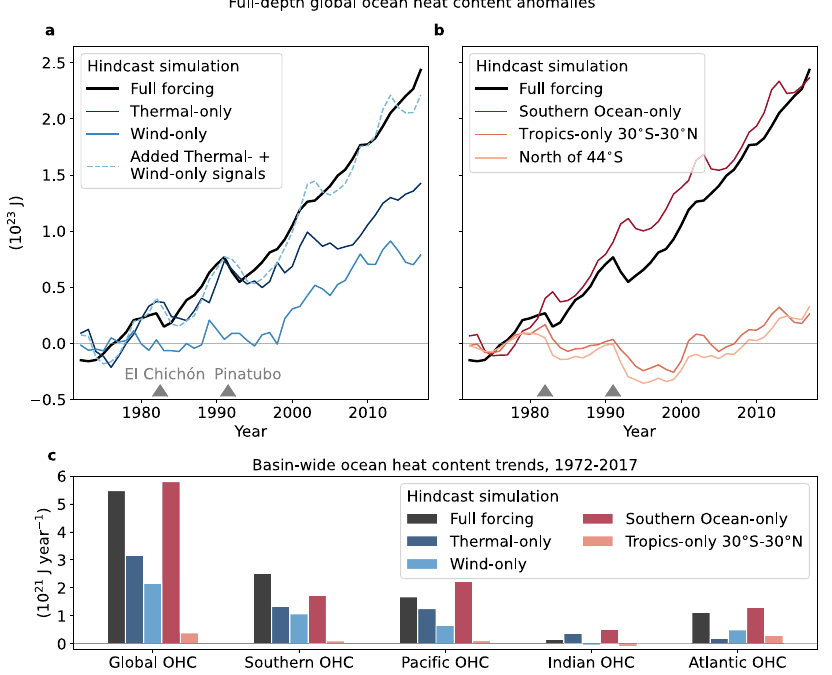
Fig.4|Simulatedglobalandregionaloceanheatcontent(OHC)changesdueto thermal/wind trends and due to regionally-constrained atmospheric trends. a Time series of full-depth global ocean heat content anomalies (10 23 J) in the full forcing simulation (black line), when only prescribing surface wind trends (i.e., Wind-only) and when only prescribing thermodynamic trends (i.e., Thermal-only, Methods). The dashed blue line shows the anomalies in both wind- and thermal- only hindcast simulations added together. The two triangle markers highlight the